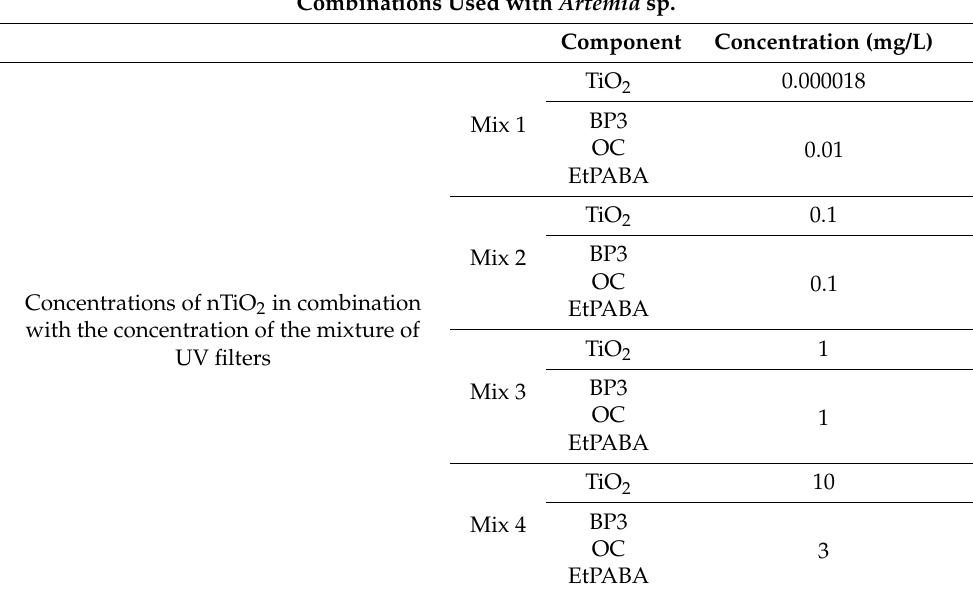
Table 2. Combination of nTiO 2 and organic UV filters mix used in the joint exposure bioassay with Artemia